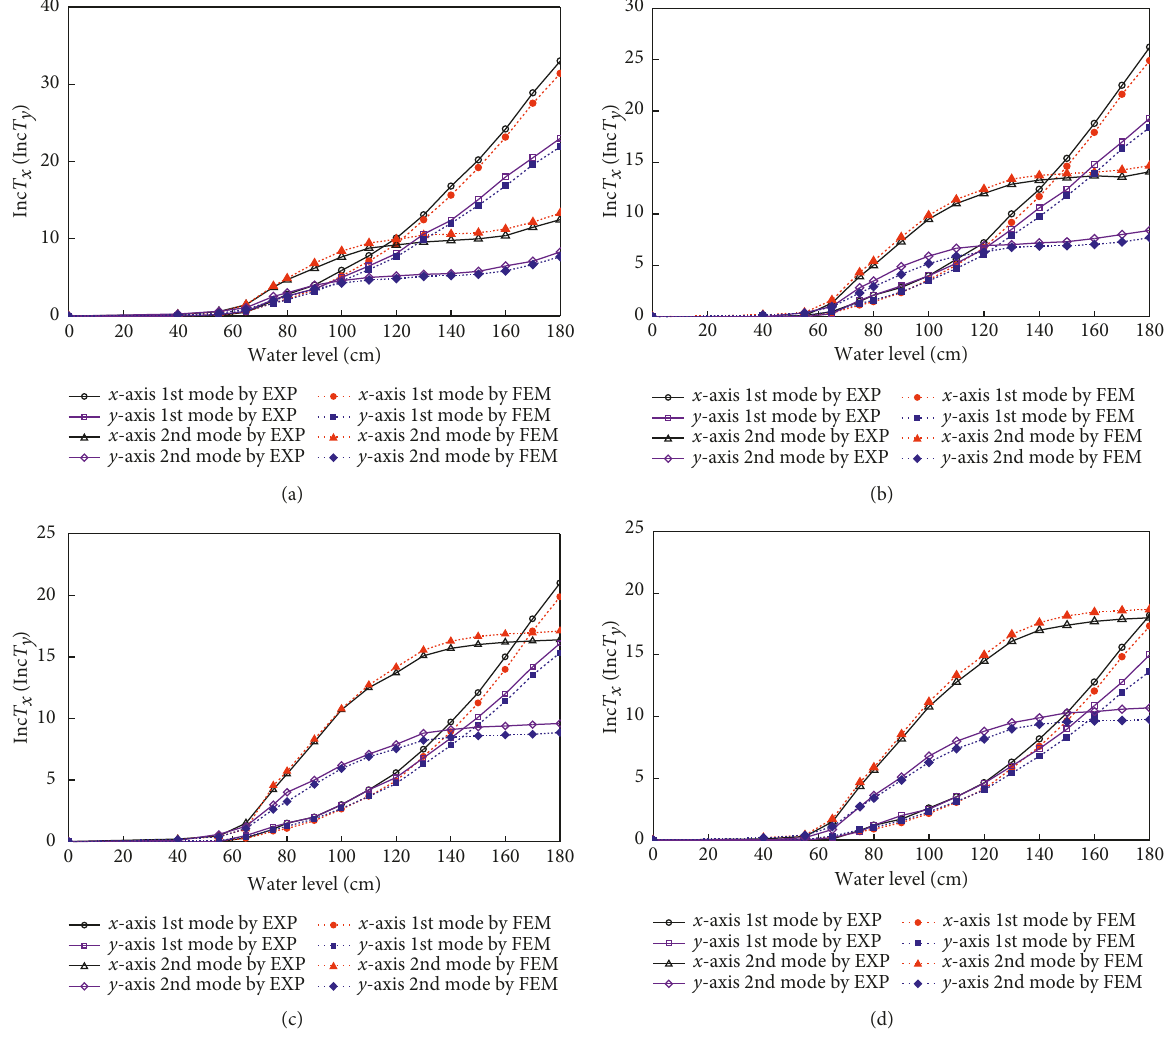
Figure 8: Measured and computed percentage increases of vibration period for the hollow pier specimen in case III as a function of water level: (a) without tip mass; (b) with an 11.4kg tip mass; (c) with a 23.4kg tip mass; and (d) with a 31.7kg tip